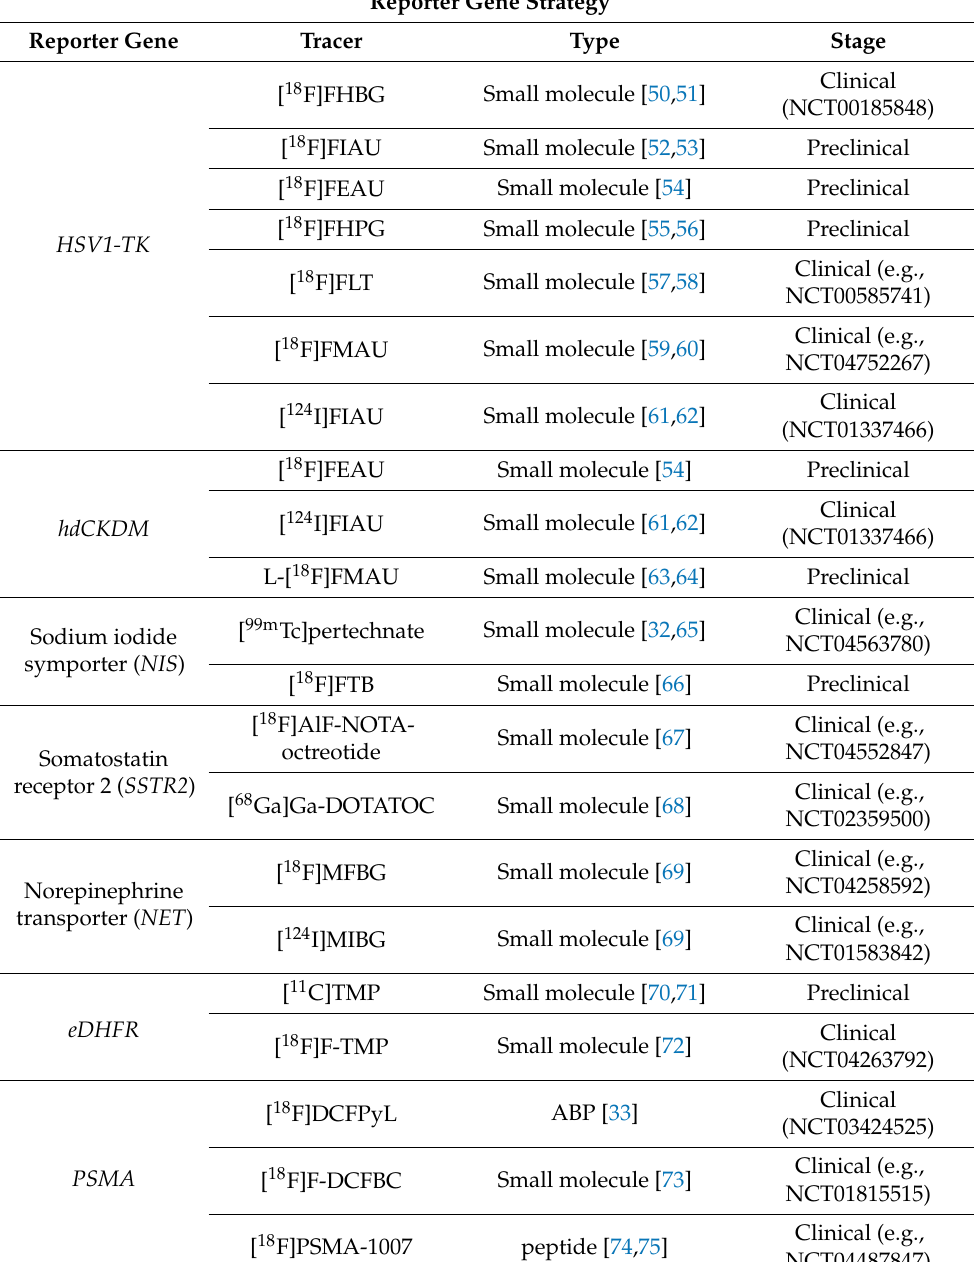
Table 2. Tracers and targets of the reporter gene method used in adoptive cell